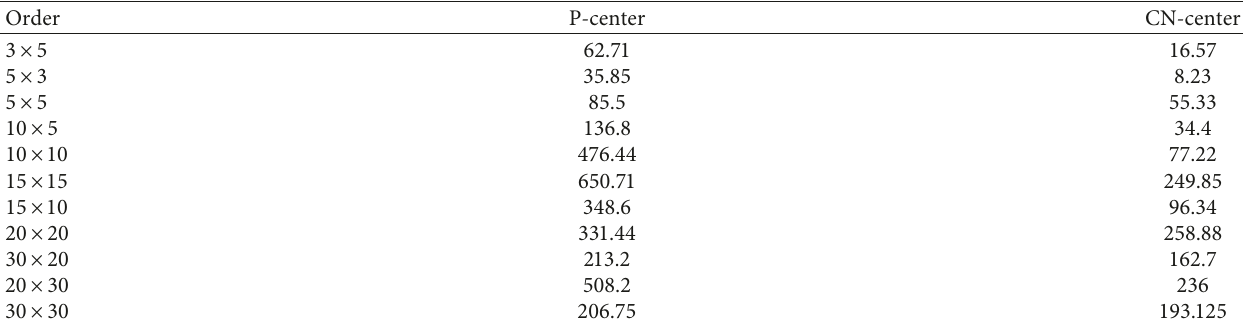
Table 4: Comparison of average number of iterations for higher dimensional random